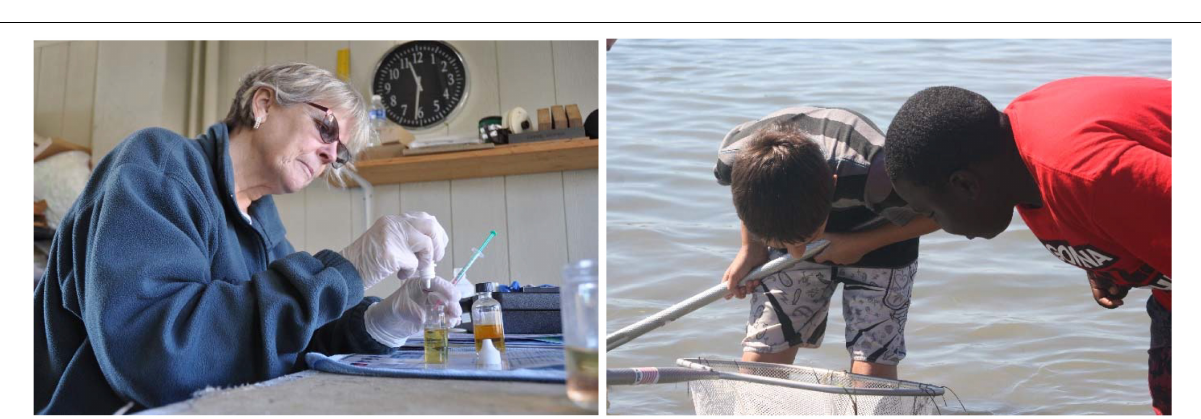
FIGURE 8 | The Gulf Citizen Science Portal, with inset showing expanded view of data—air and water temperature, dissolved oxygen, pH and salinity, available at one station (Leffis Key, FL).